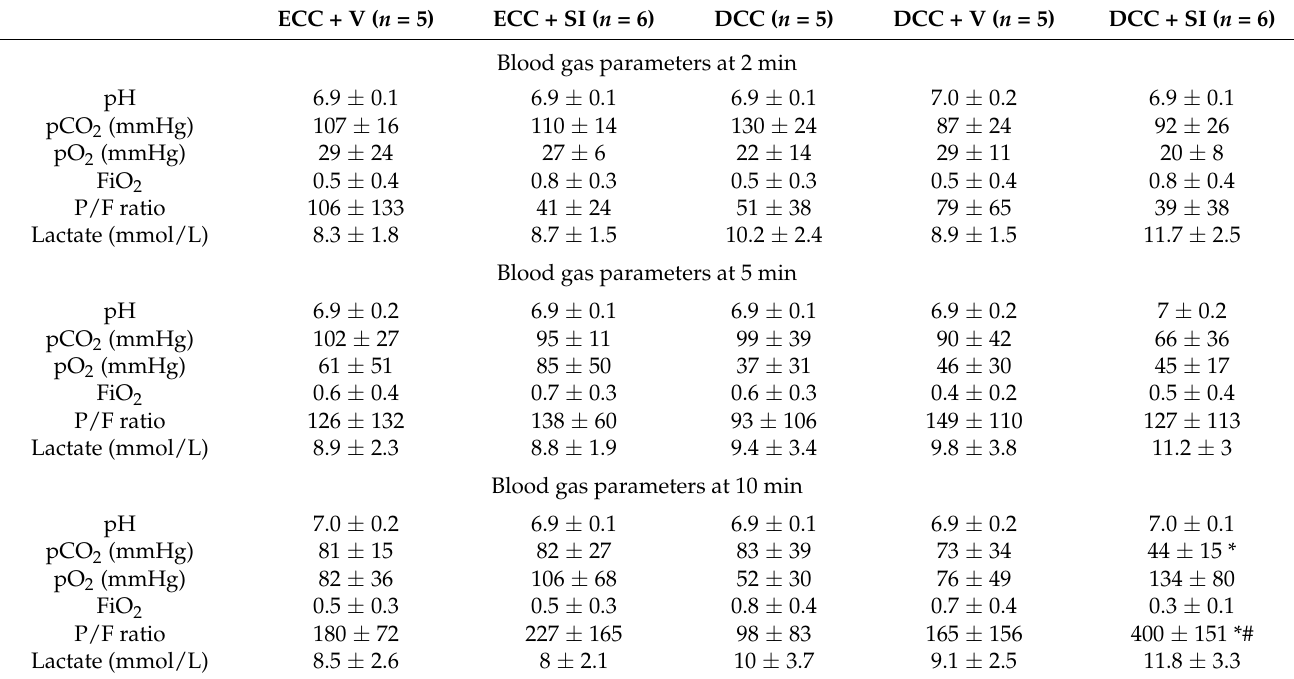
Table 3. Gas exchange parameters.